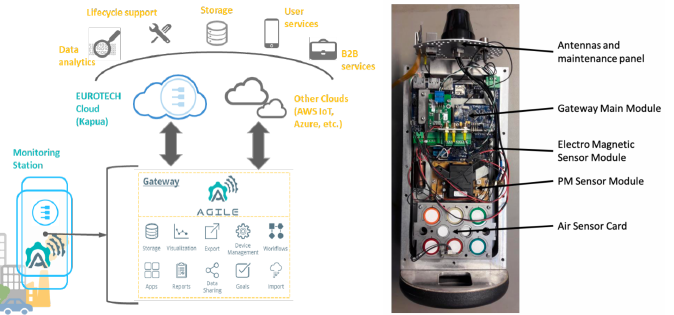
Figure 4. The industrial pilot architecture and the prototype of the Air Pollution Monitoring Station (APMS).